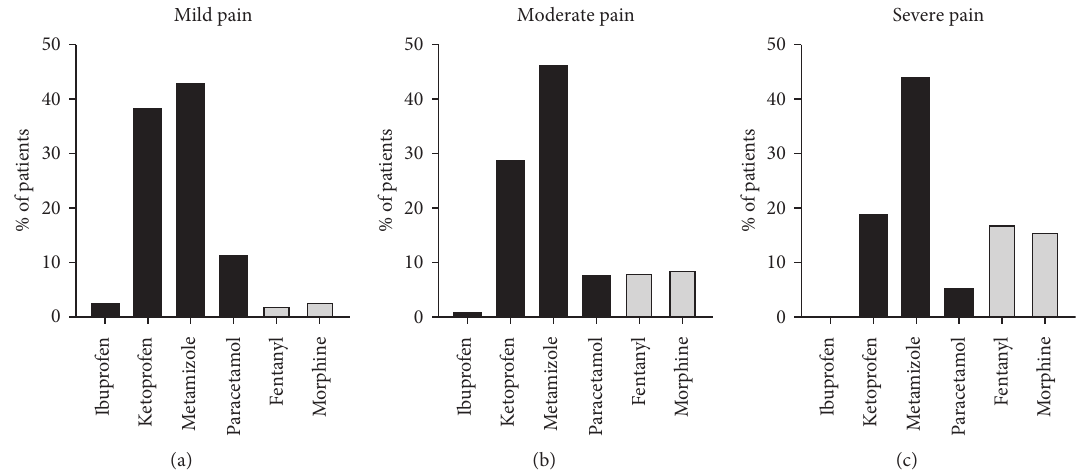
Figure 2: The frequency of use of analgesics in the group with mild (a), moderate (b), and severe (c) pain. Black colour indicates nonopioid drugs, and gray indicates